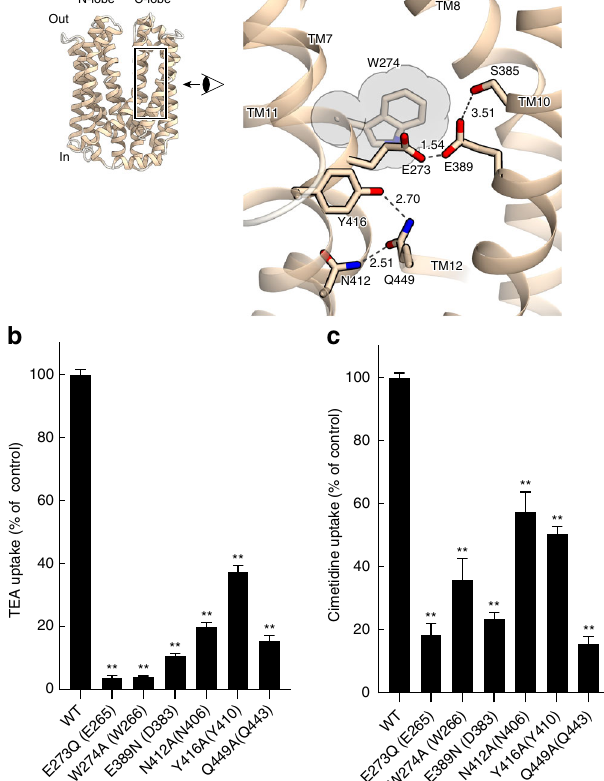
Fig. 5 Homology model of hMATE1 and transport assay. a Homology model of hMATE1 and close-up view of the hydrogen-bonding network in the C-lobe. The model structure was generated by the program MODELLER 42 , using the AtDTX14 structure as the template. The residues involved in the hydrogen-bonding network were manually adjusted, using the program COOT 38 . In the close-up view, Trp274 is represented by a CPK model (gray). b , c Uptake of [1- 14 C]-labeled TEA ( b ), and [ N -methyl- 3 H]-labeled cimetidine ( c ) into HEK-293 cells expressing hMATE1 mutants. Activities relative to that of the wild type (WT) are shown. The control activity (100%) of TEA and cimetidine correspond to 6 ± 0.17 nmolmg − 1 protein and 47 ± 2.7 pmol mg − 1 protein, respectively. The labels on the horizontal axis indicate the mutated amino-acid residues of each hMATE1-mutant (AtDTX14 numbering is indicated in parentheses), n = 8 – 33. Data